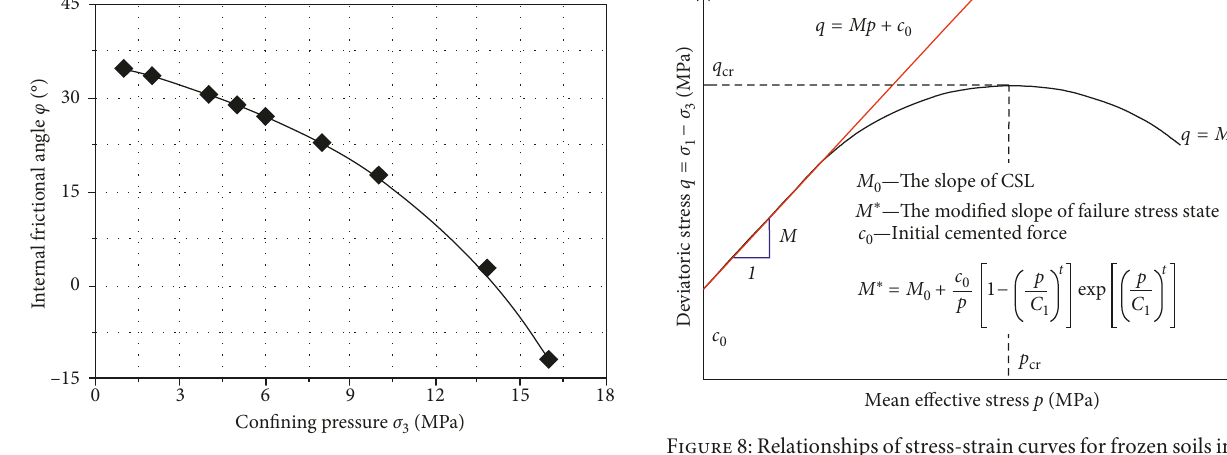
Figure 8: Relationships of stress-strain curves for frozen soils in the meridian